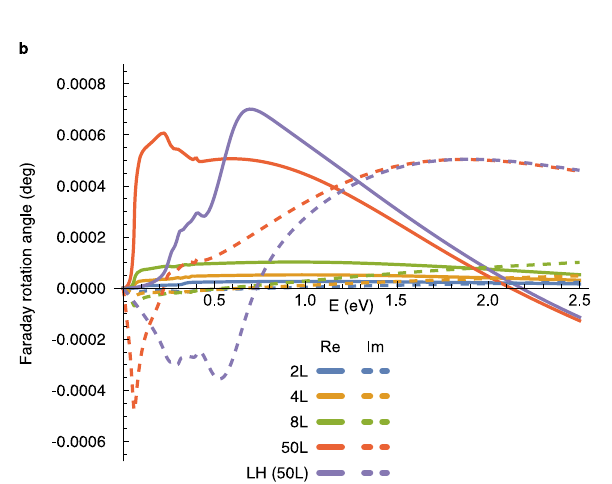
model itself is obtained from the electric dipole susceptibility through ffiffiffiffiffiffiffiffiffiffiffiffiffiffiffiffiffiffiffiffiffiffiffiffiffiffiffi p 1+ χ xx ð ω Þ = ϵ 0 . For LH, we calculate the axion angle from the layer Hall n 2 ð ω Þ = conductivity with periodic boundary conditions and use the thickness of 50 layers for ϕ = n 2 ω d / c . All optical response functions are calculated with γ =10meV to broaden the resonance through ω → ω + i γ .